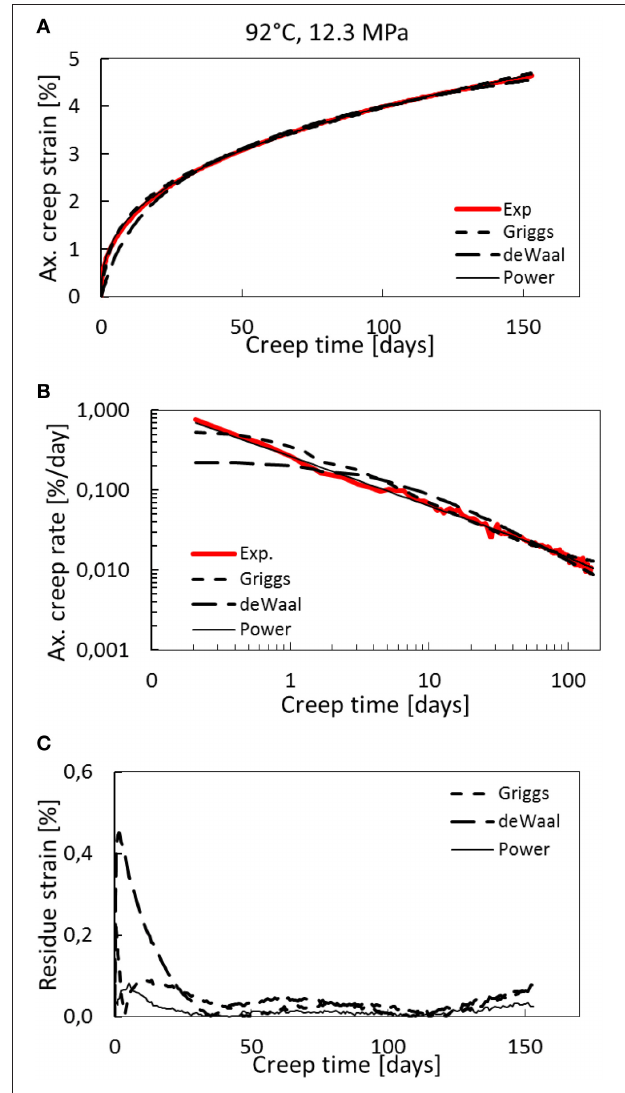
FIGURE 5 | Creep curves for the 92 ◦ C and 12.3MPa effective stress experiment (OBSV25). (A) Axial creep strain curves compared to the best fit of power law with exponential cutoff, de Waal and Griggs models. (B) Logarithmic strain rate (in %/day) plotted with logarithmic time-axis. (C) Residual strain through time. The power law curve fits the data better than the de Waal and Griggs